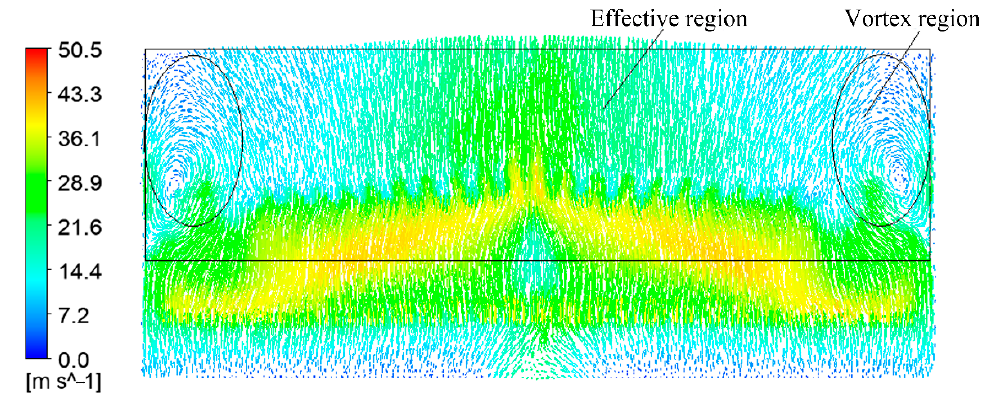
Figure 14. Velocity vector diagram of cross section 4.